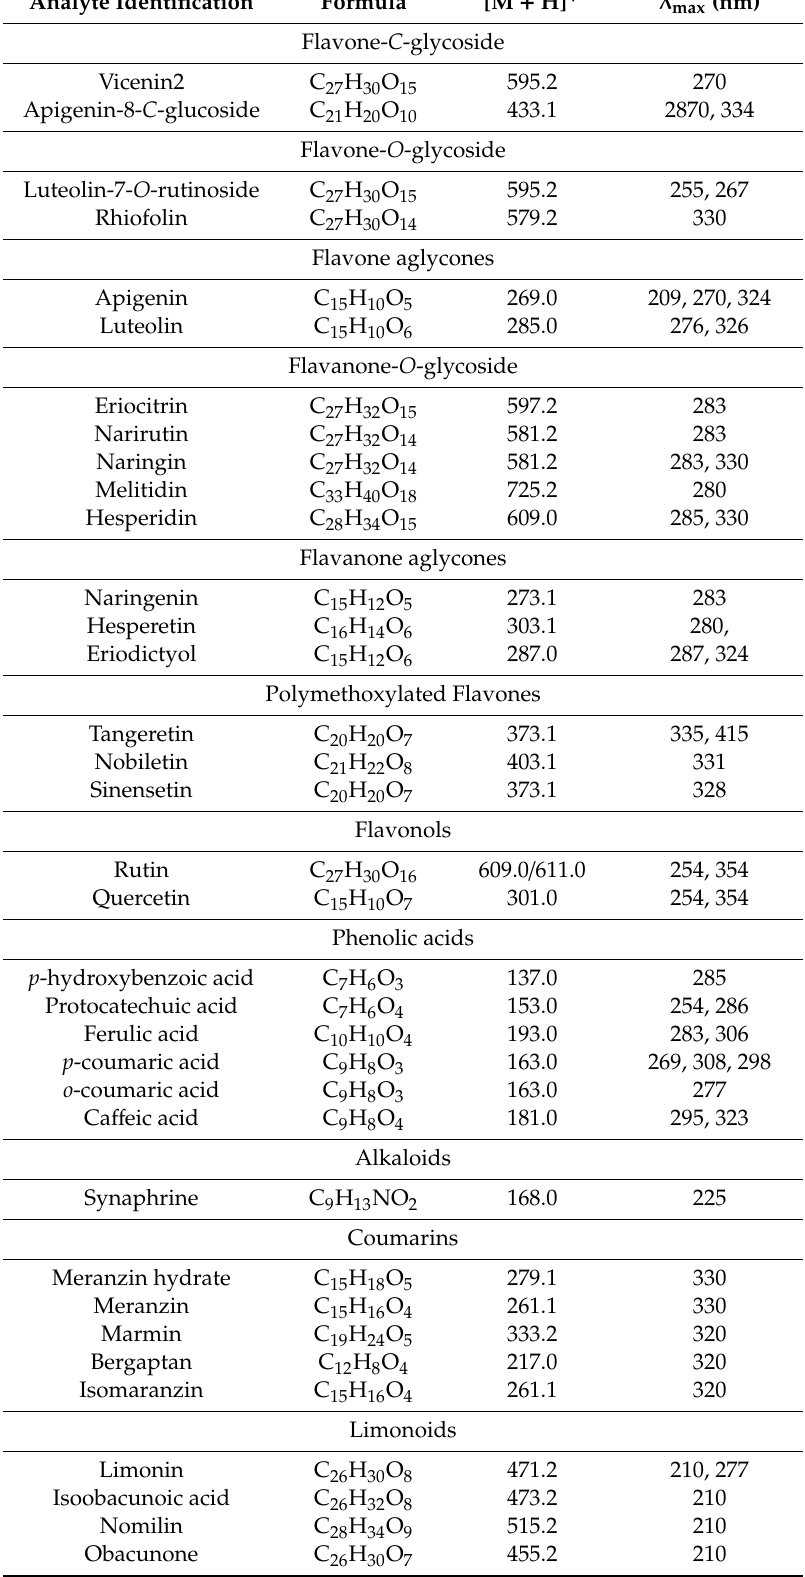
Table 15. Identification of the chemical constituents in citrus phytochemicals by UV-visible and mass spectroscopy